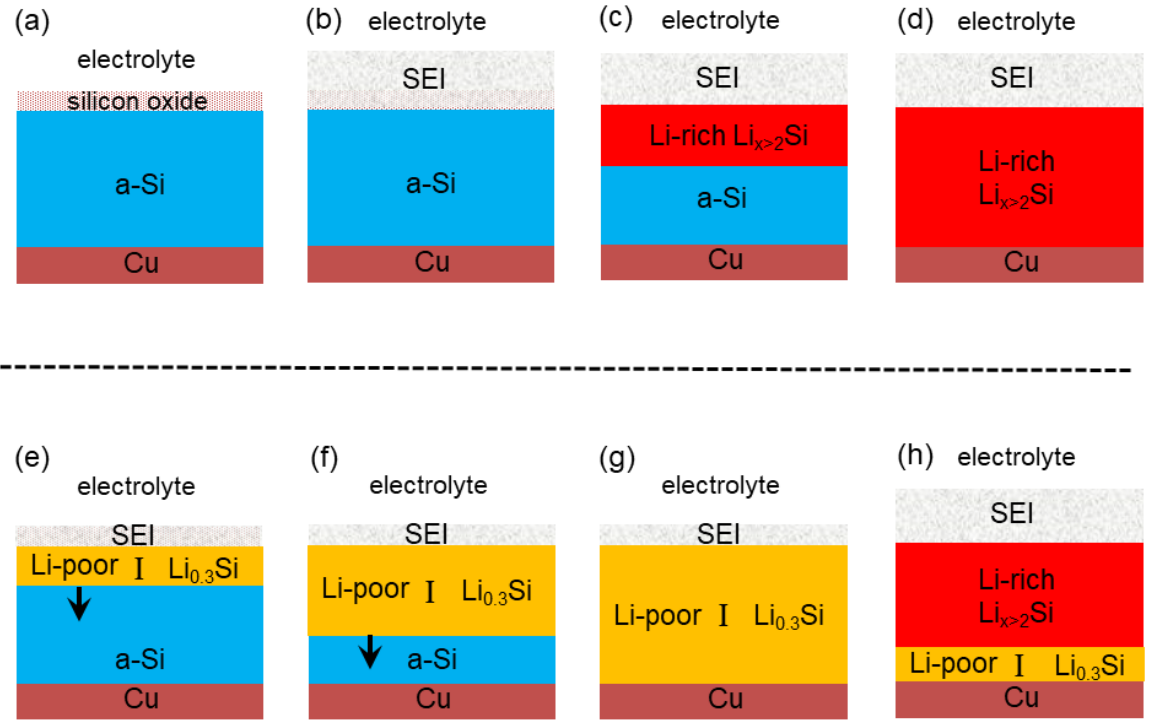
Figure 1. Schematic of two possible lithiation mechanisms (with and without a Li-poor silicide phase) of an a-Si film in the first lithiation process, summarizing the introduction section of this work. Shown are cross sections of the Si film (blue) during the lithiation of the first cycle. The copper current collector is marked with brown. ( a – d ) Schematic of the lithiation process of the a-Si film